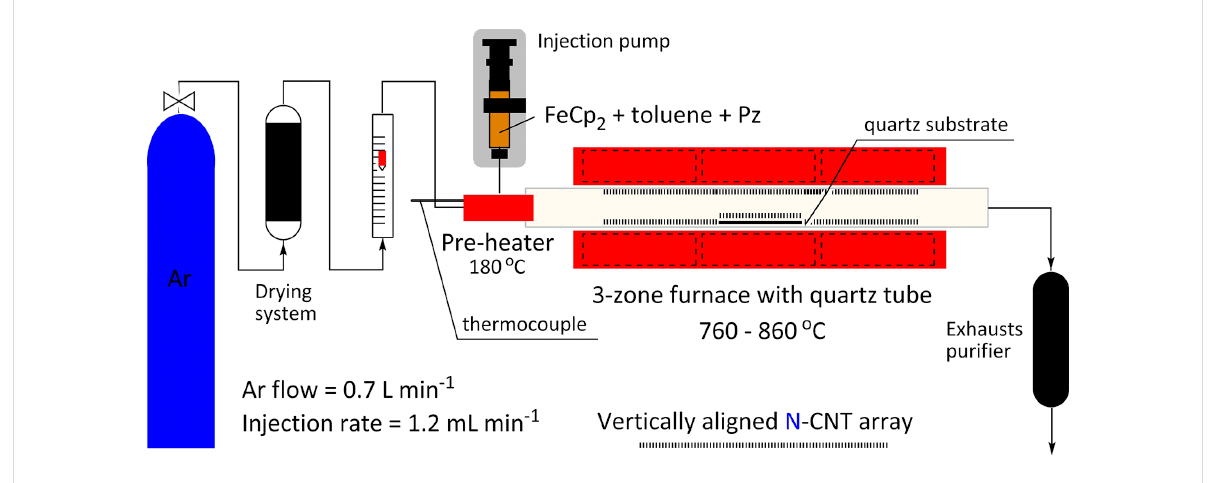
Figure 1: Injection c-CVD furnace and constant parameters for the synthesis of aligned N-CNT arrays.